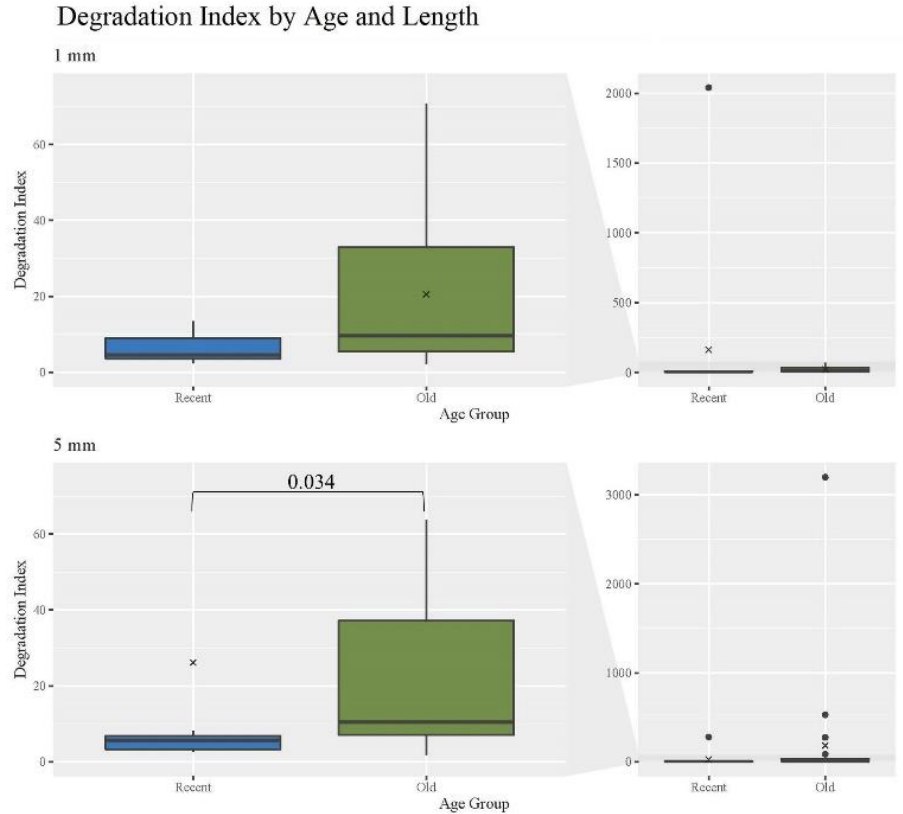
Figure 3. Boxplots for the comparison of degradation index for each age group and length (n = 74; n R = 26, n O = 48). The ‘x’ on the boxplots represents the mean and the line represents the median. Bracket shows comparison with significant p -value ( p < 0.05).